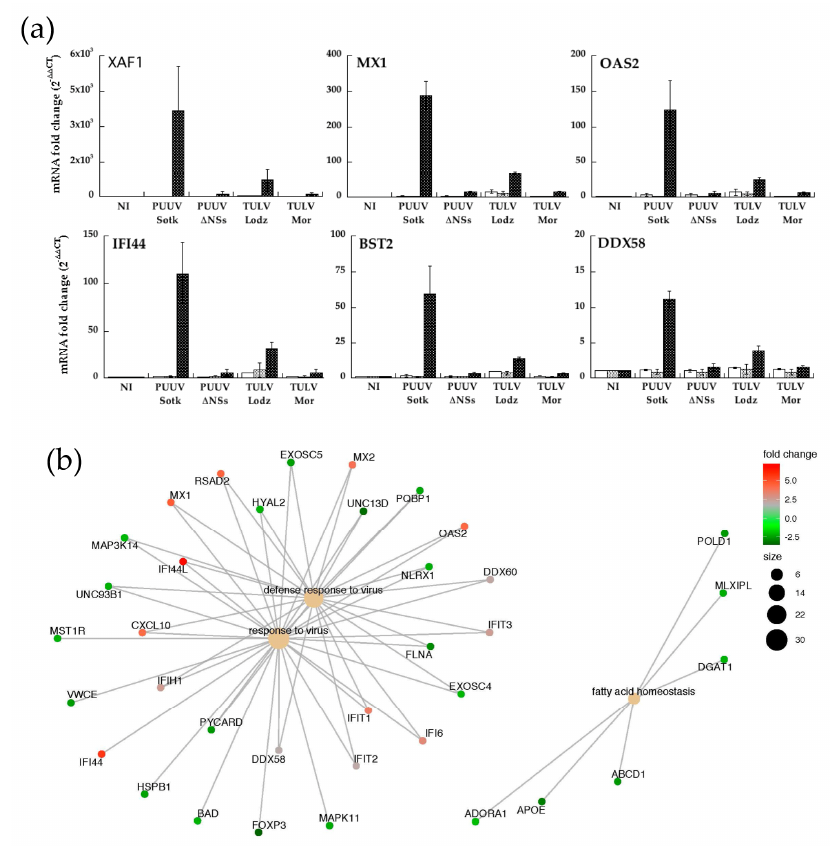
Figure 7. Regulation of expression of genes involved in innate immunity in A549 cells infected by different PUUV or TULV strains. Histograms in ( a ) represent the relative expression (log2 fold change) of XAF1, MX1, OAS2, IFI44, BST2, and DDX58 mRNA determined by quantitative RT-PCR at dpi 1 (white bar), dpi 2 (grey bar) and dpi 5 (black bar) in infected A549 cells. The error bars correspond to standard deviation to the mean of data from biological triplicates. ( b ) Cnetplot visualization of cellular mRNA identified by transcriptomics using R clusterProfiler package implemented in R: central nodes (pale brown) outline over-represented biological functions, and node size corresponds to the number of identified genes associated to them, as shown in the legend. Peripheral nodes represent genes, and their level of regulation, expressed as fold change compared to non-infected cells, displayed using a red-green gradient: strongly up-regulated genes are depicted in red, weakly up-regulated in light grey, and down-regulated ones in